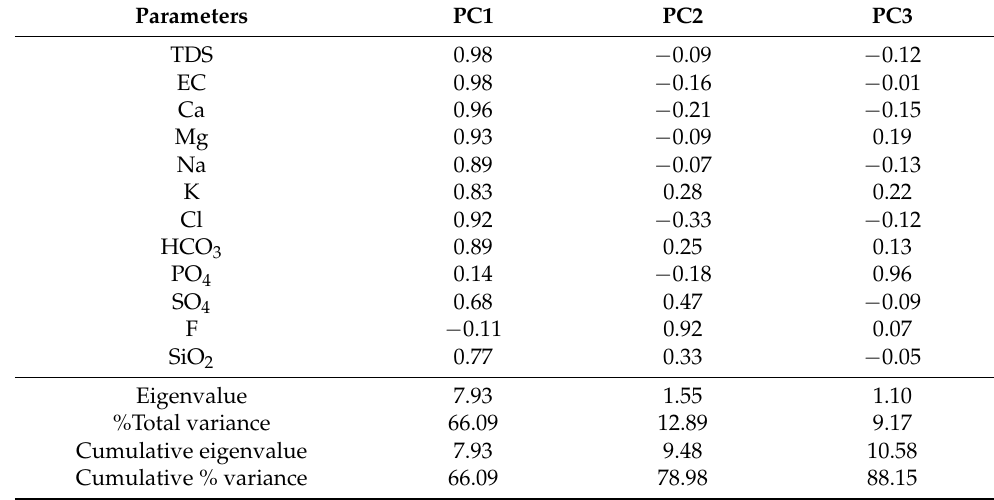
Table 5. Principal component analysis (PCA) of the groundwater samples.